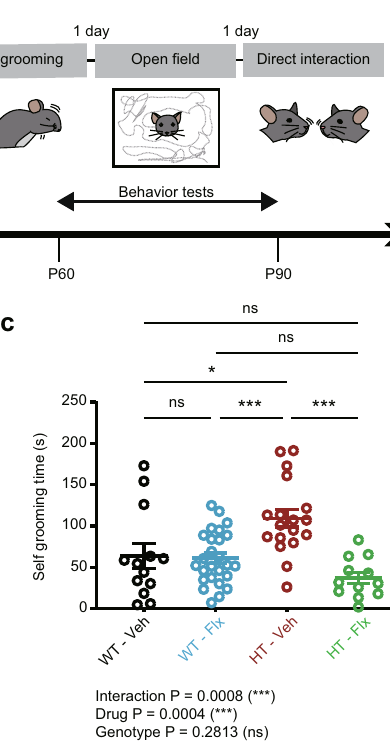
p =0.9899,WT-VehvsHT-Flx: p =0.0058,HT-VehvsWT-Flx: p <0.0001,HT-Vehvs HT-Flx: p =0.0132, WT-Flx vs HT-Flx: p =0.0010]). c Early, chronic fl uoxetine